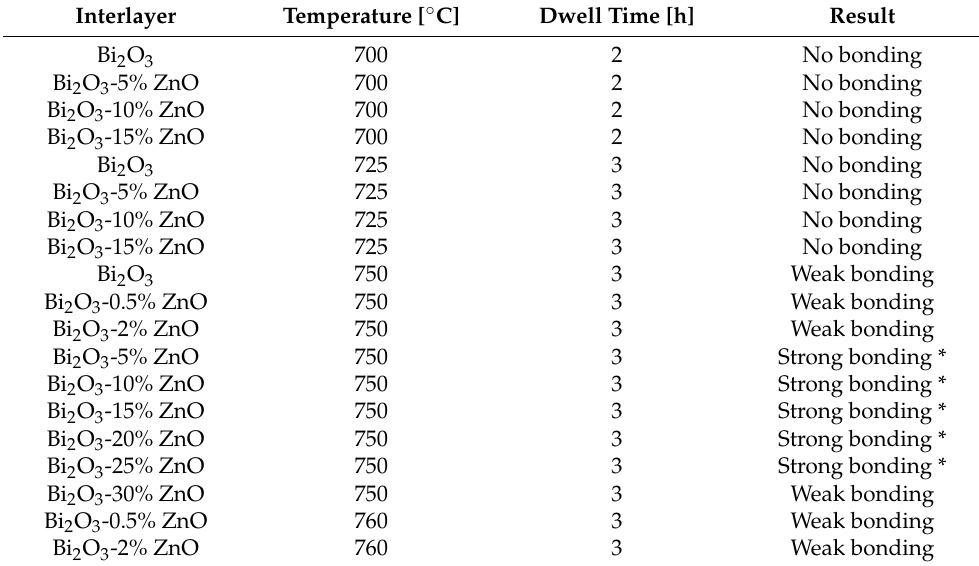
Table 1. Details and results of conducted joining